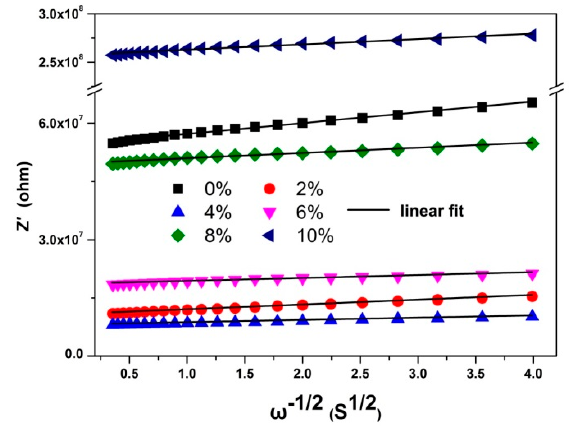
Figure 5. The Z ′ ~ ω -1/2 plots of YF 3 :Eu 3+ nanocrystals at low frequencies.